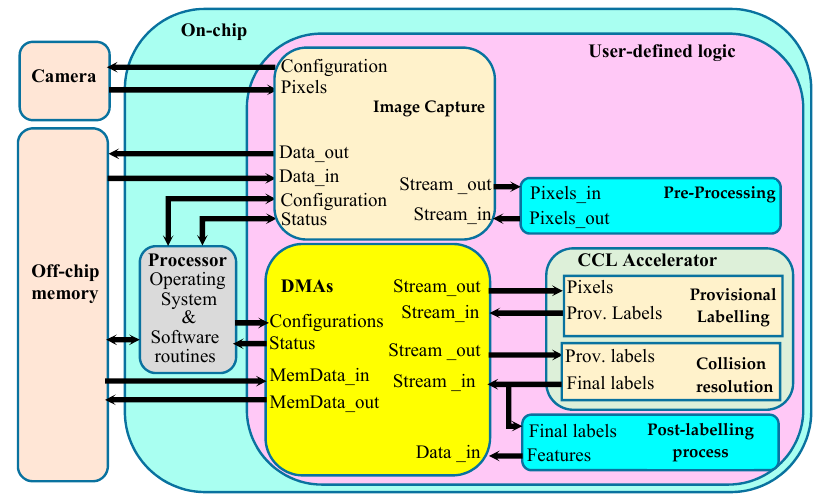
Figure 1. Architecture of a heterogeneous embedded system.